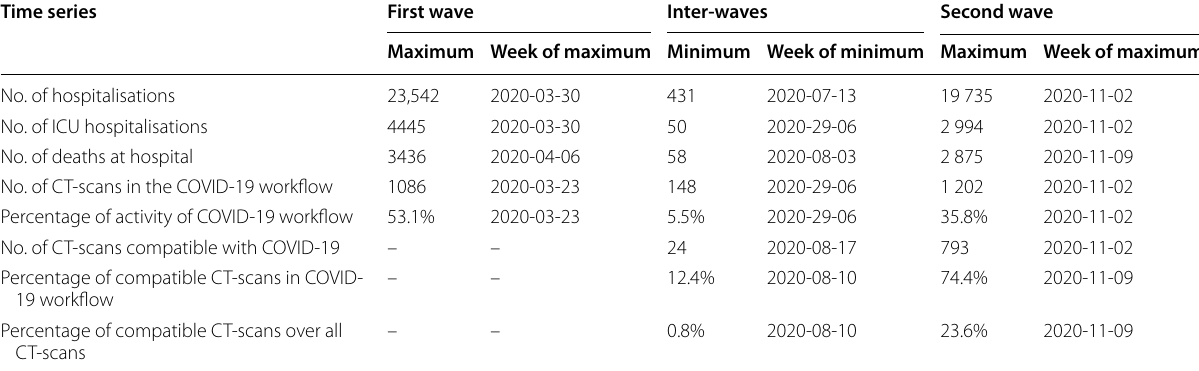
Lines 1–3: epidemiological data from the French public health agency (Santé Publique France) Lines 4–8: teleradiological